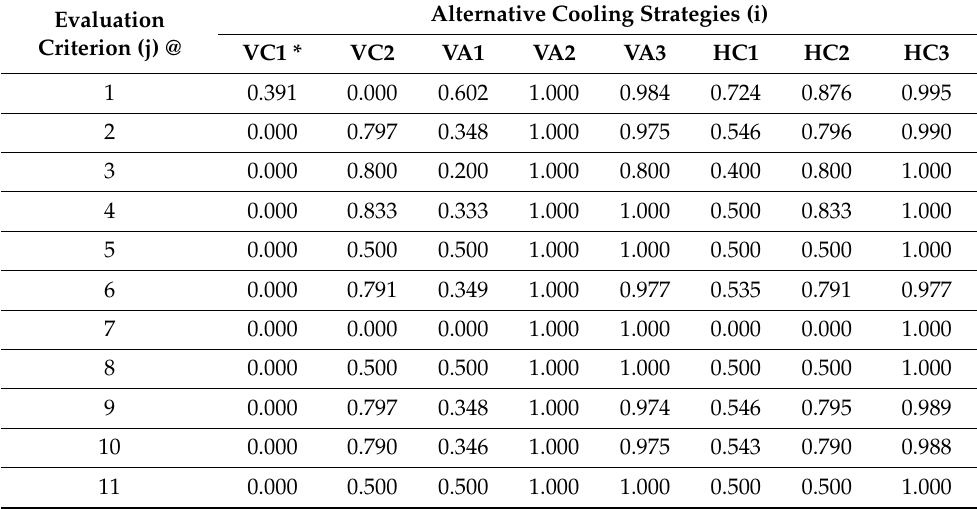
for cooling temperate continental climatic zone. ij